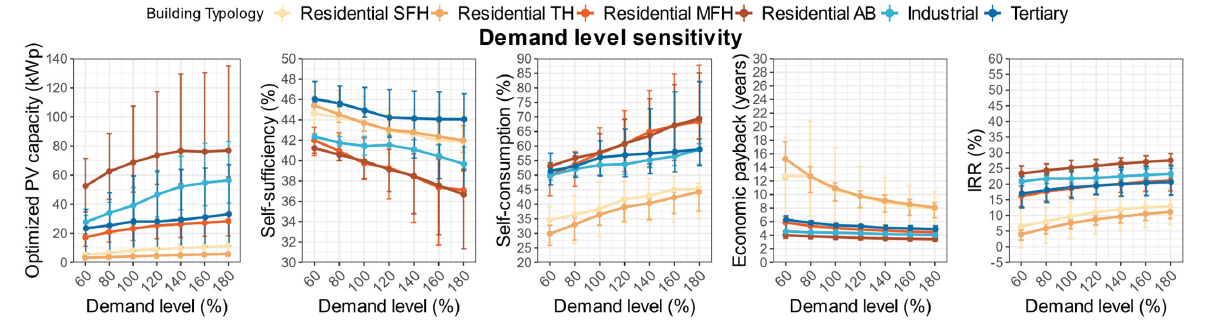
Figure 10. Sensitivity of the main PVSC variables as a function of DL with respect to the NB base scenario for the selected sample of buildings.